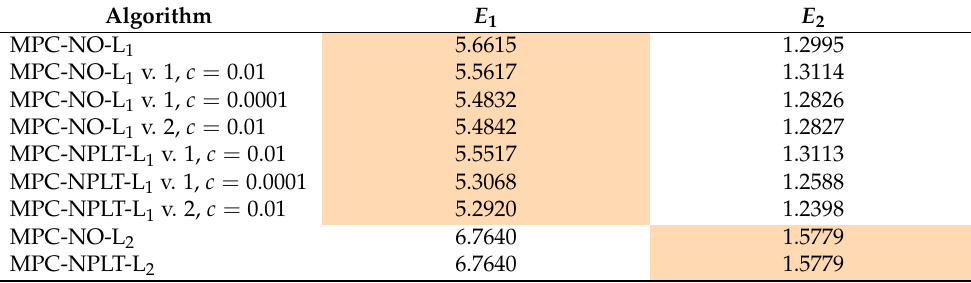
Table 2. Simulation results: E 1 and E 2 indices; the coloured control quality indicators correspond to the minimised cost-function used in MPC.